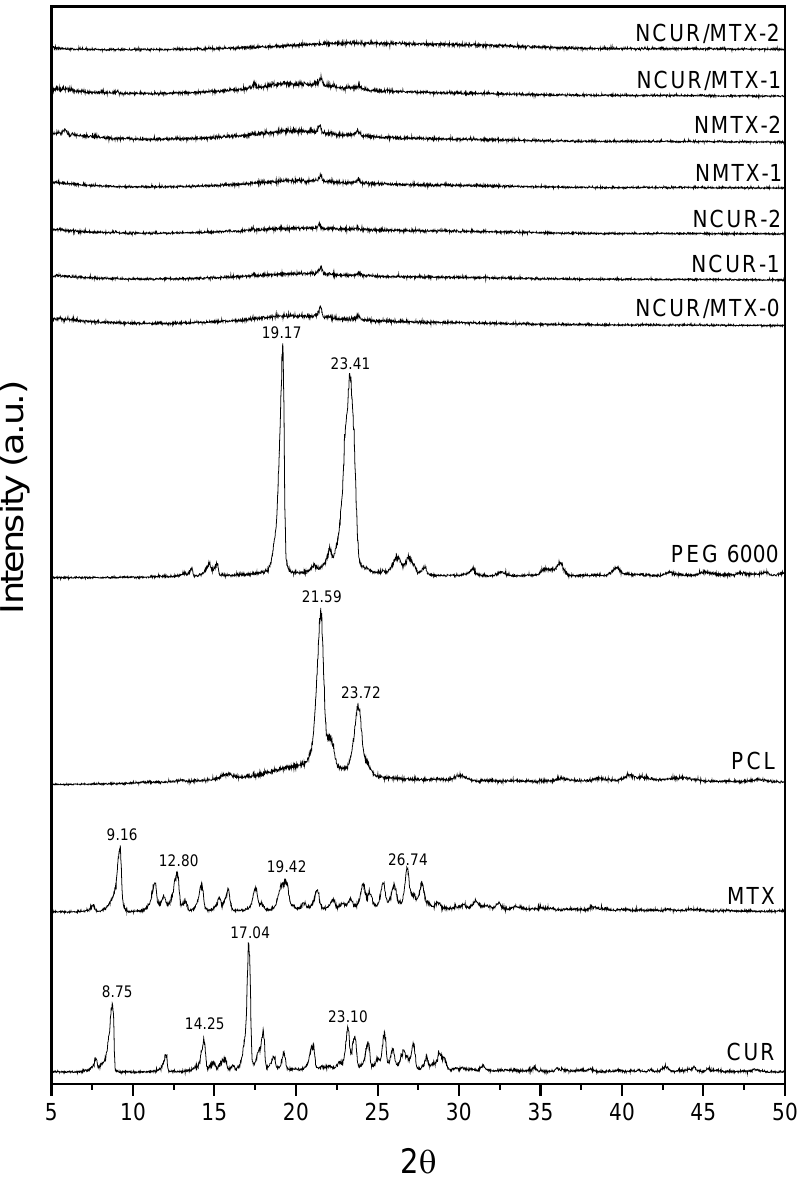
Figure 2. Di ff ractograms of CUR, MTX, PCL, PEG 6000, and CUR and / or MTX-loaded and non-loaded Figure 2. Diffractograms of CUR, MTX, PCL, PEG 6000, and CUR and/or MTX-loaded and non-loaded NCs obtained by XRD NCs obtained by XRD analysis.